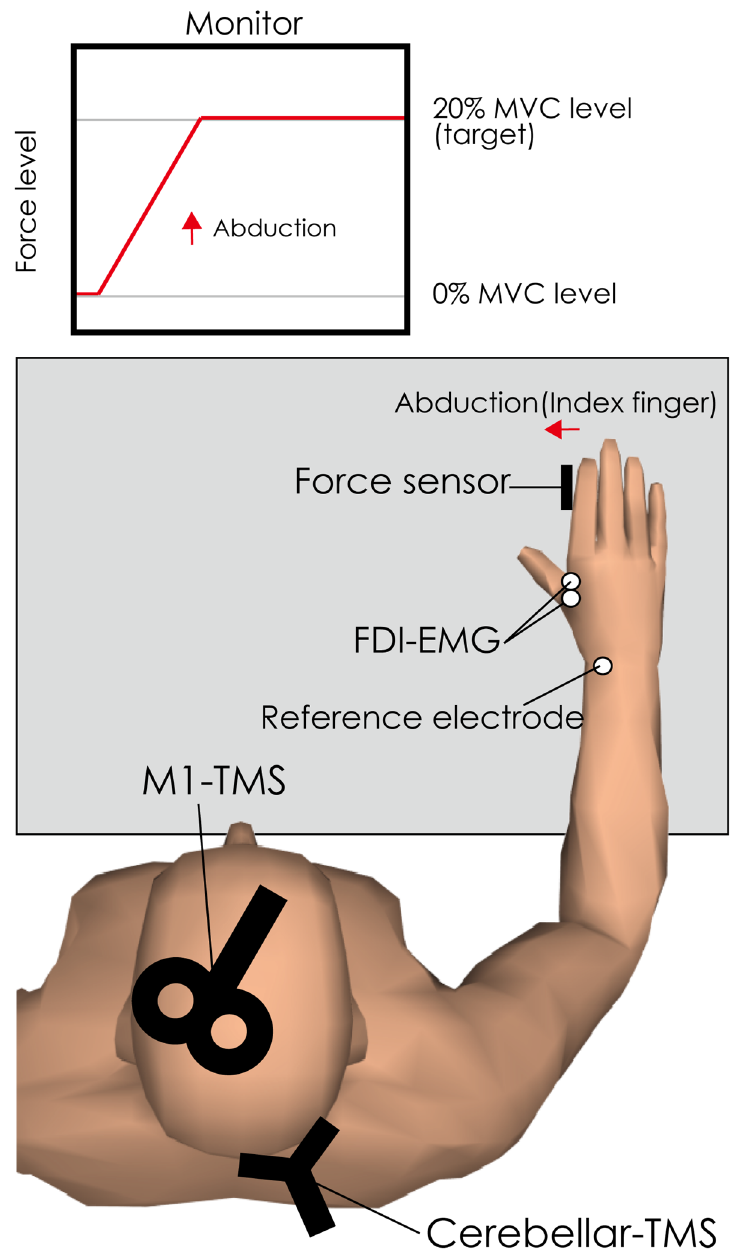
Figure 1. Experimental setup for first and second experiment. The subject was seated in front of a computer monitor. The right hand was fixed with metal frames, and a force sensor was set on the abduction side of the index finger to record the actual output force of abduction of the index finger. The feedback of the actual output force level was provided visually. The subject was instructed to set the force level to the target level (20% of maximum voluntary contraction) with abduction of the index finger. The crossover region of the figure-of-8 coil was set over the hotspot of the right first dorsal interosseous in the left primary motor cortex. The center of the region of double-cone coil was set on site 1 cm under and 3 cm to the right of the inion. FDI; first dorsal interosseous, EMG; electromyography, MVC; maximum voluntary contraction, M1; primary motor cortex.